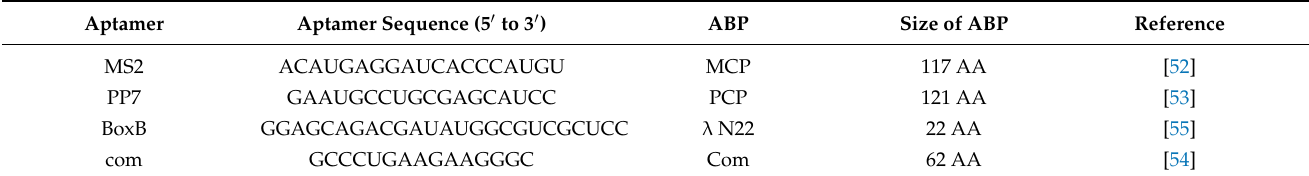
Table 1. Aptamer and aptamer-binding protein (ABP) used for VLP-mediated RNA/RNP